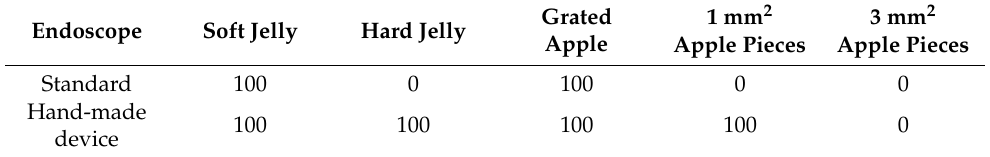
Table 1. Successful residue removal rate in the ex vivo study (three attempts for each residue).